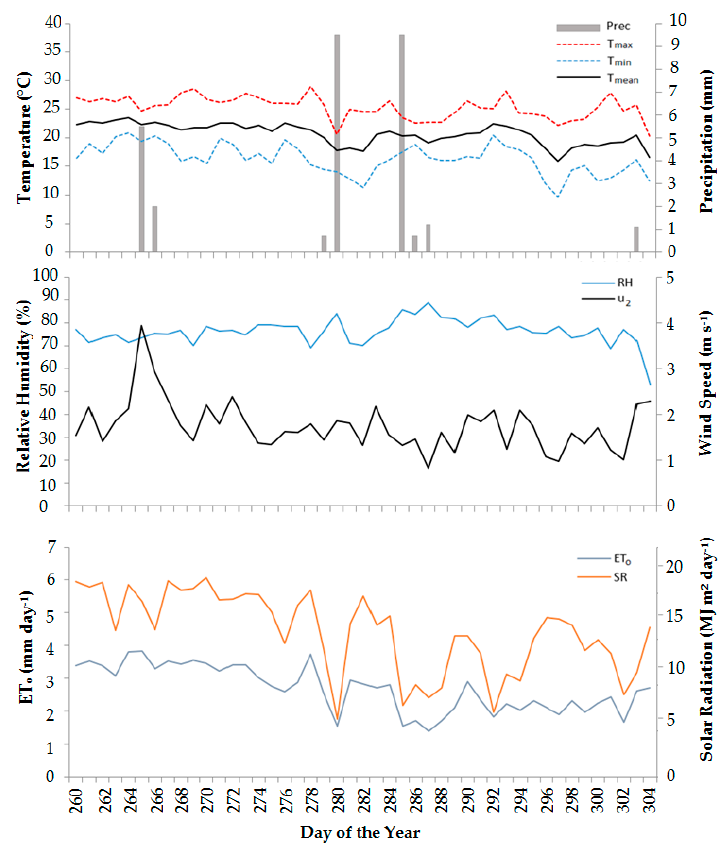
Figure 2. Daily weather data obtained from the weather station located at San Javier, Murcia (code TP22; http://siam.imida.es) for the period including the lettuce growing season in 2016. Abbreviations: Prec = precipitation; T mean = mean temperature; T max = maximum temperature; T min = minimum temperature; RH = relative humidity; u 2 = wind speed; ET o = reference evapotranspiration; SR = solar radiation.